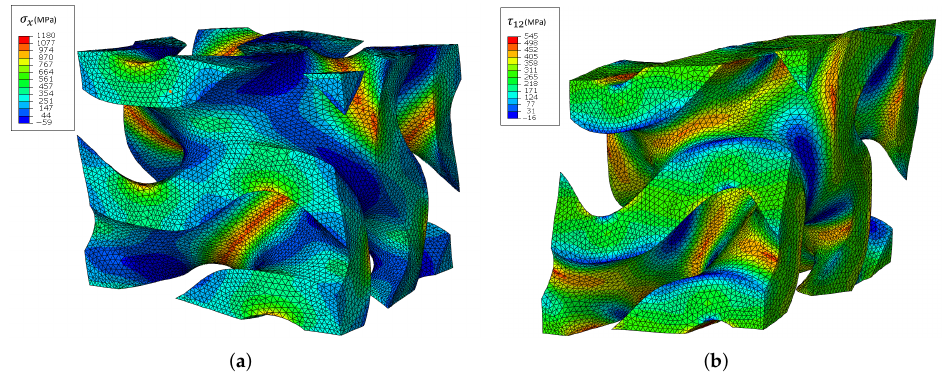
Figure 5. Deformed shape and stress distribution of a gyroid solid model (50% relative density). ( a ) Longitudinal deformation and stress ( σ x ); ( b ) shear deformation and stress ( τ xy